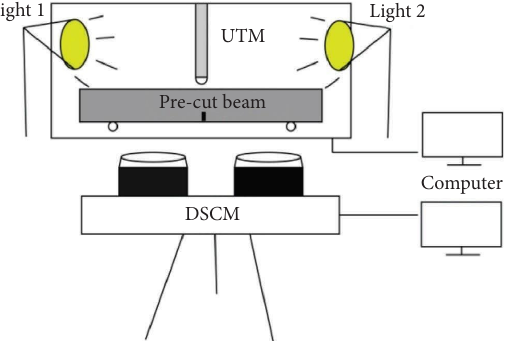
Figure 3: Tree-point bending test and VIC-3D analysis.